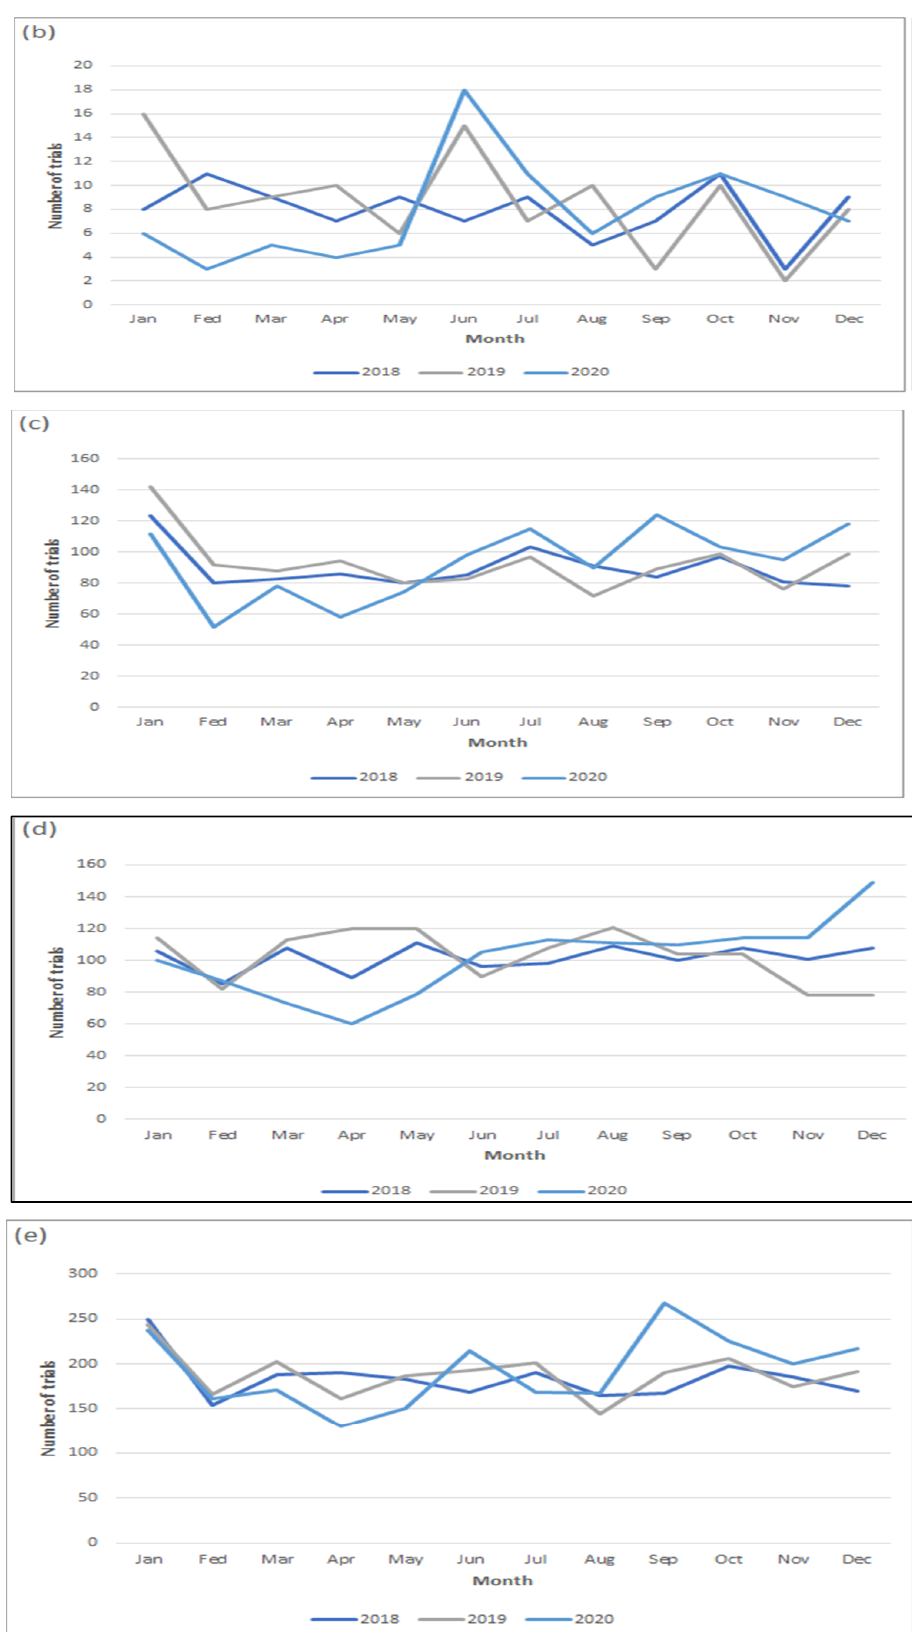
Figure 4. Monthly trends in the commencement of new oncology trials according to funding source from 2018 to 2020. ( a ) Industry; ( b ) government; ( c ) other; ( d ) academia; and ( e ) cofunded.